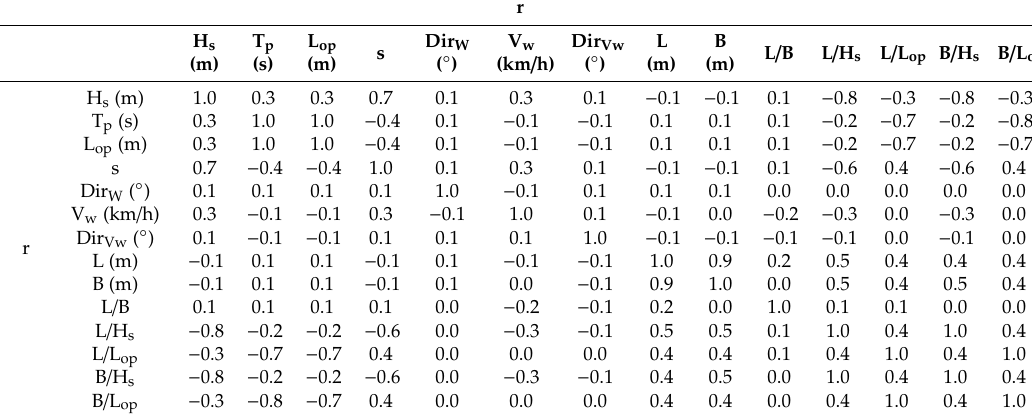
Table 6. Pairwise Pearson linear correlation coefficients for the predictors (in gray when r ≥ 0.6 or r < −